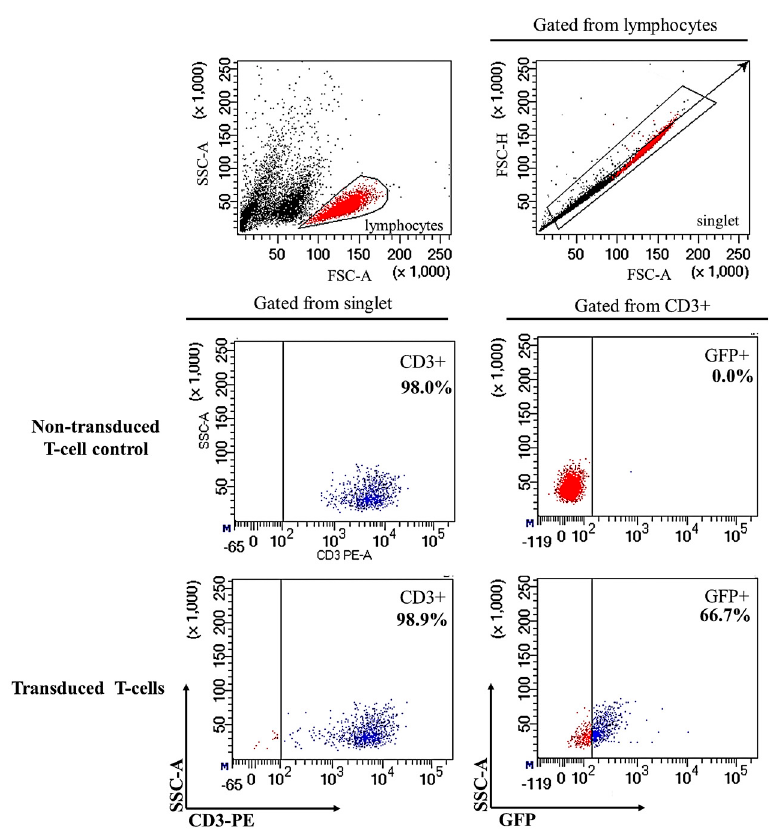
Figure 2. Verification of the transduction efficiency based on flow cytometric analysis of CAR-transduced human T-cells (CAR-T cells). The transduction efficiency was evaluated by the percentage of GFP-positive T-cells 72 h post-transduction. The cell population was gated at lymphocytes. Singlet was gated from the lymphocyte population to remove residual cell clumps following disaggregation and eliminate auto-fluorescence. Subsequently, CD3+ cells were gated from the singlet population, and GFP+ cells were gated from the CD3+ population. The GFP positive cells indicate that 66.7% of T-cells were successfully transduced with CAR -encoding lentiviral particles, generating CAR-T cells. CD3 was stained by fluorochrome phycoerythrin (PE). For each antibody, isotype-matched mouse immunoglobulin γ antibody was used as the isotype control.